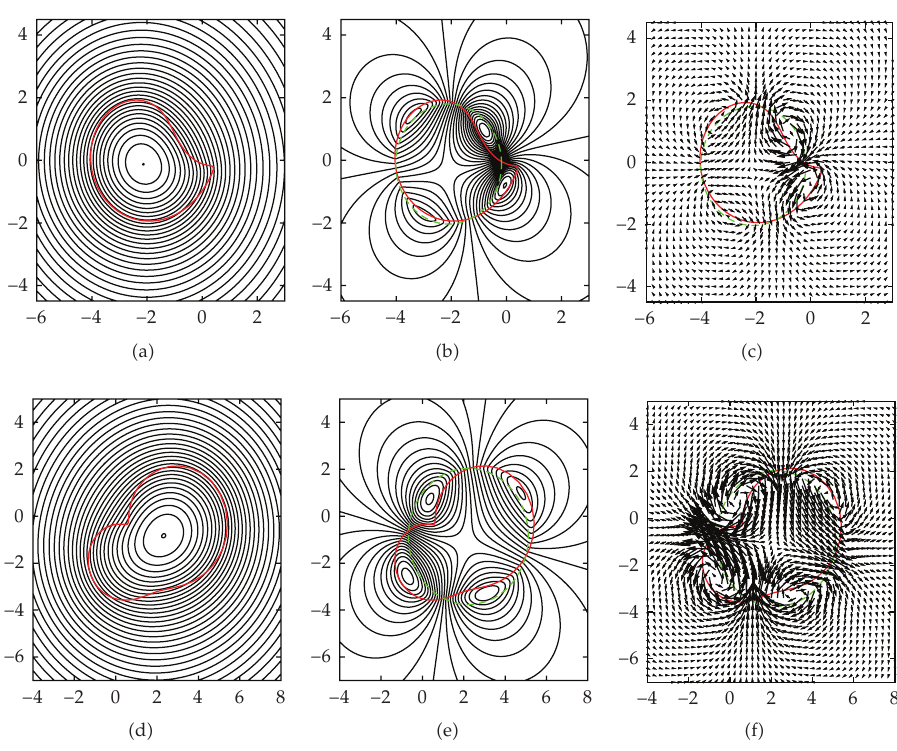
Figure 7: (cid:2) a (cid:3) , (cid:2) d (cid:3) The streamlines (cid:2) blue lines, (cid:2) a (cid:3) Δ ψ (cid:7) 0 . 1 and (cid:2) d (cid:3) 0 . 2 (cid:3) are drawn for the vortices in Figures 3 (cid:2) c (cid:3) and 3 (cid:2) f (cid:3) , respectively. (cid:2) b (cid:3) , (cid:2) c (cid:3) , (cid:2) e (cid:3) , (cid:2) f (cid:3) The boundaries of the vortices are drawn with thick red lines, while the ones of the equivalent Rankine vortices with green dashed lines. The di ff erential streamlines and velocities (cid:2) with a scale factor of 3 (cid:3) are shown in (cid:2) b (cid:3) (cid:2)Δ ψ (cid:7) 0 . 01 (cid:3) , (cid:2) e (cid:3) (cid:2) 0 . 04 (cid:3) , and (cid:2) c (cid:3) , (cid:2) f (cid:3) ,